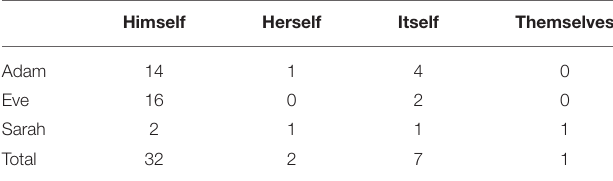
TABLE 3 | Number of reflexive pronouns in maternal